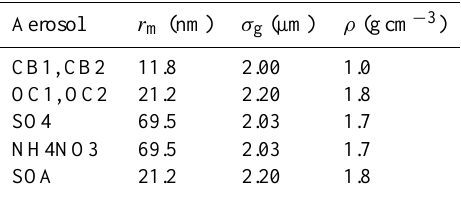
Table 5. Bulk aerosol parameters used in calculation of surface area: number distribution mean radius ( r m ), geometric standard de- viation ( σ g ) and